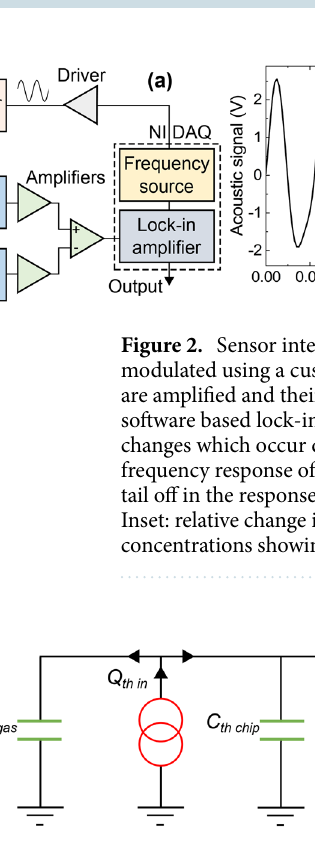
Figure 3. Numerical analysis. ( a ) Simplified thermal model illustrating the heat flow from the microheater into the gas and chip due to their thermal capacities C th and resistance R th of the chip under DC heating. A temperature rise Δ T occurs on the microheater due to the flow of heat. ( b ) Experimental vs. numerical calculations showing the relative pressure change in the thermal acoustic cavity with varying volumetric fractions of CO 2 , modelled with and without compensation for the photoacoustic effect. ( c ) Mid-infrared absorption spectrum with 20% CO 2 in air at 0.1 mm absorption length, under standard conditions (296 K, 1